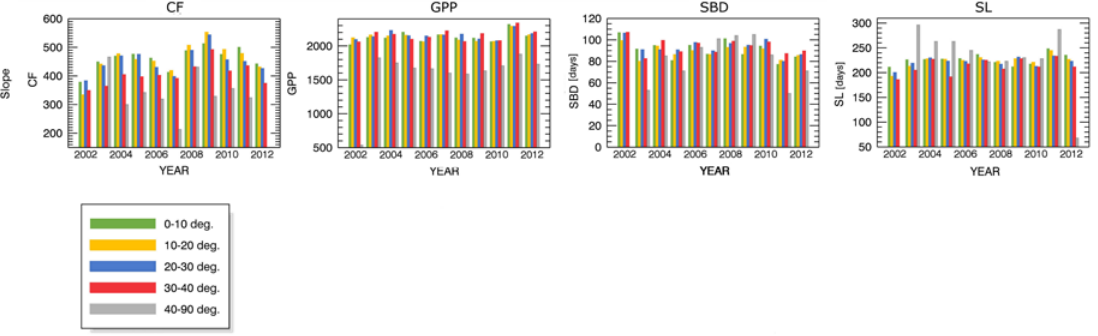
Figure A2. Marginal means plots of repeated measures ANOVA showing CF, GPP, SBD and SL variability in relation to slope. Analyses performed for the 4nNDII7 drought impact class 1 spatial footprint. Abbreviations are explained in Table A1.